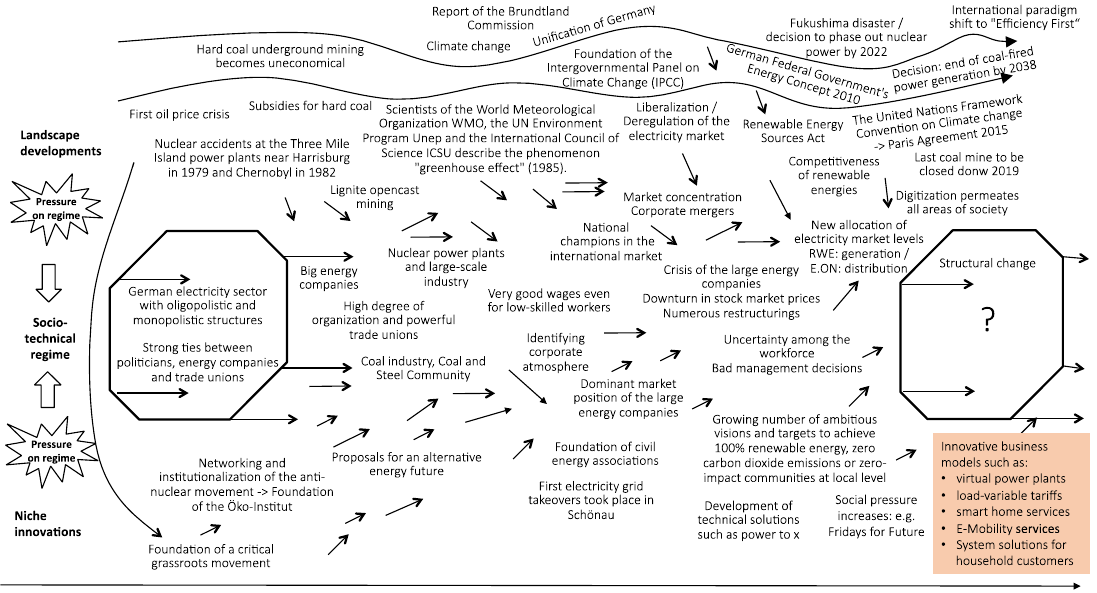
Figure 5. Overview of the key influences on the German electricity regime, presented using the multi-level perspective according to Geels. Depiction based on Geels (2002) [16].